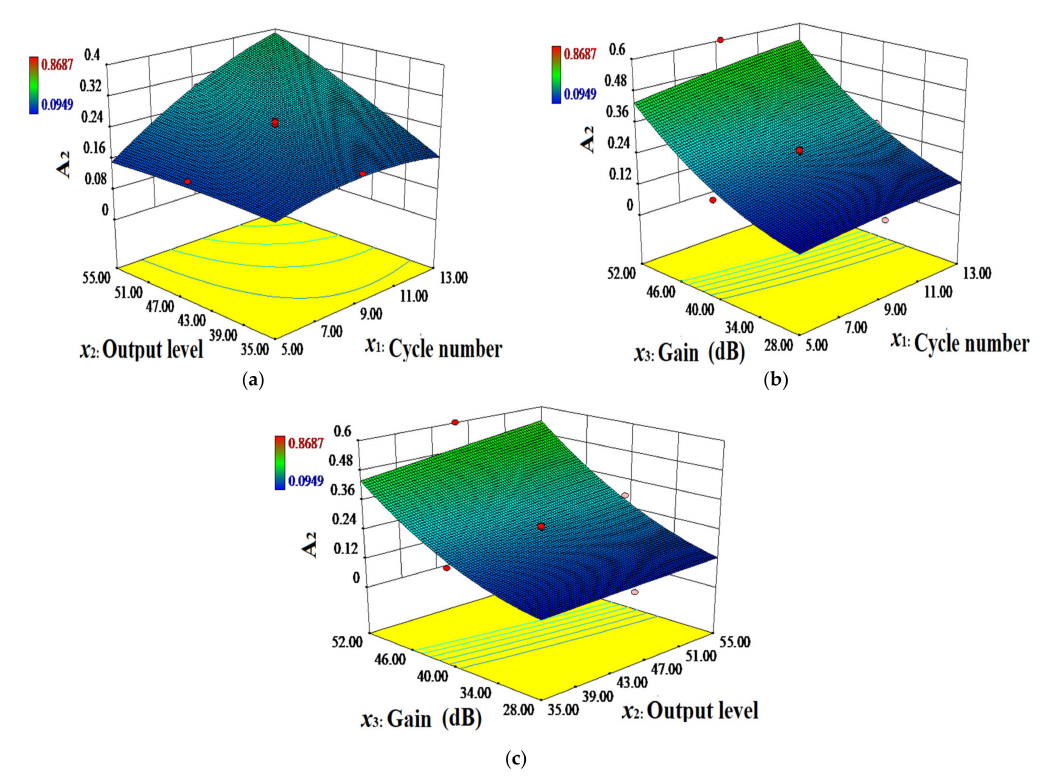
Figure 11. Three-dimensional (3D) response plots: ( a ) Cycle number ( x 1 ) and output level ( x 2 ), ( b ) cycle number ( x 1 ) and gain ( x 3 ), ( c ) output level ( x 2 ) and gain ( x 3 ), and their mutual interactions with A 2